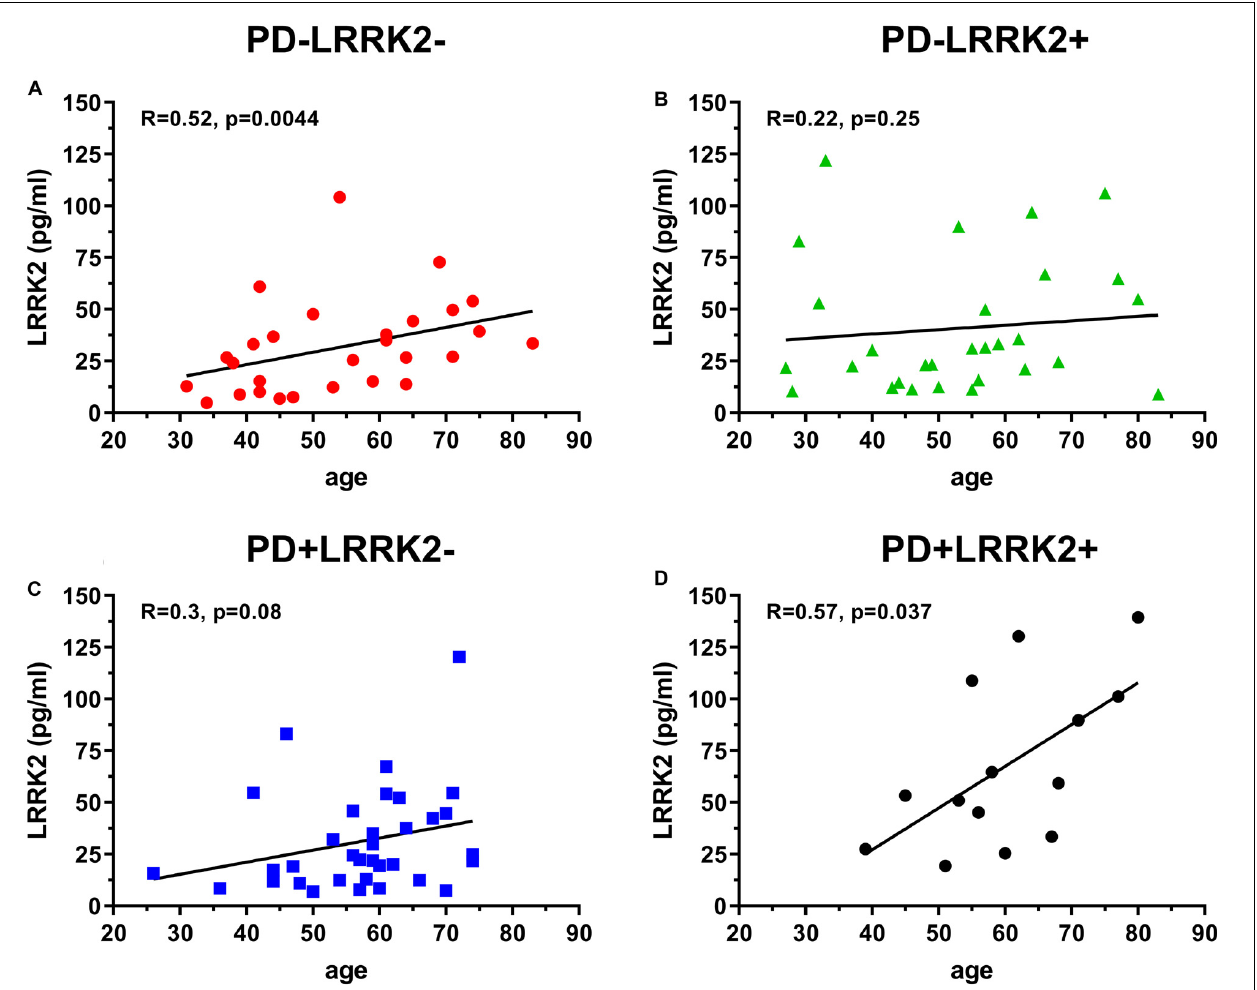
FIGURE 5 | 106 CSF samples were analyzed using the LRRK2 SISCAPA assay. Of the 106 samples analyzed, 105 had measurable LRRK2 levels. Overall correlation between CSF LRRK2 levels and age in the LRRK2 Cohort Consortium samples using Spearman’s rank correlation in the PD-LRRK2- (A) , PD-LRRK2+ (B) , PD+LRRK2– (C) , and PD_LRRK2+ (D)